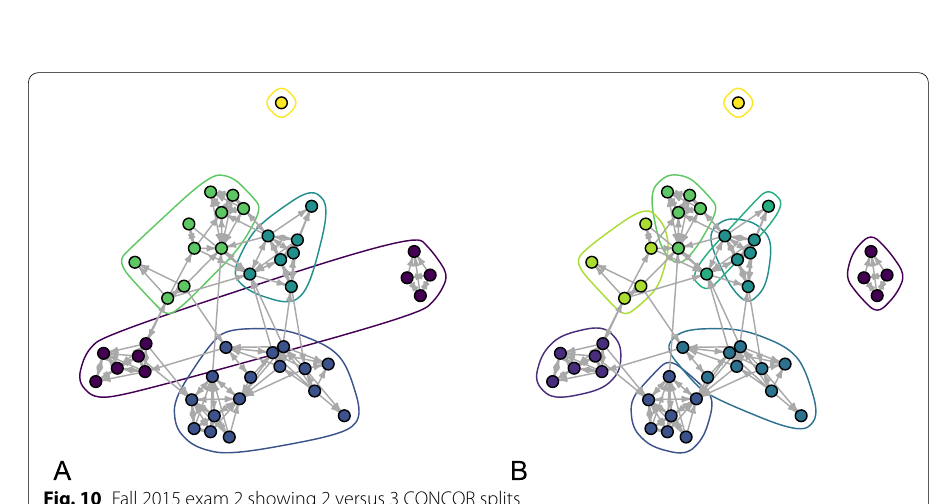
Fig. 10 Fall 2015 exam 2 showing 2 versus 3 CONCOR